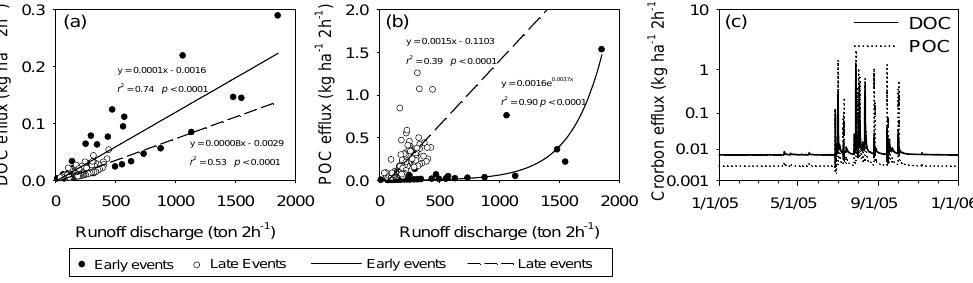
Fig. 6. Relationship between (a) the stream discharge and DOC, (b) stream discharge and POC, and (c) the estimation of the annual organic carbon efflux from the Gwangneung deciduous forest catchment. Early and late events indicate E050626, E050701, and E050709, E050824, E050913, E050930, respectively.